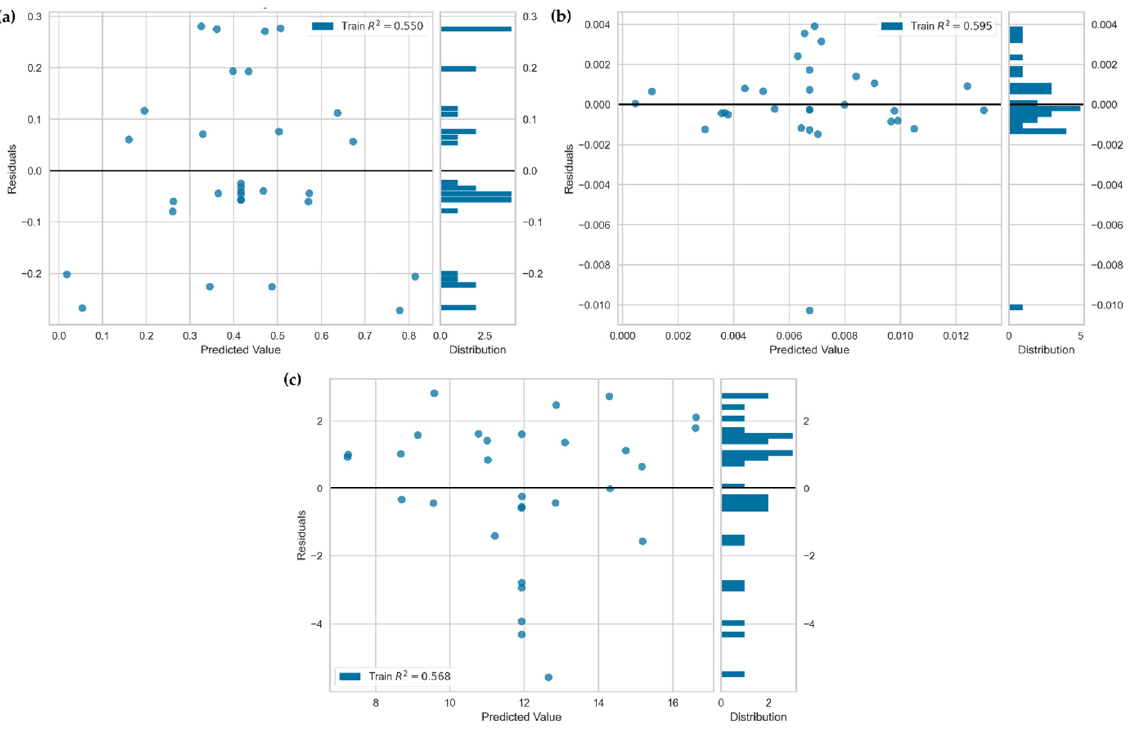
Figure 3. Residuals versus linear regression predicted ( a ) MRR ( b ) EWR ( c ) SR.